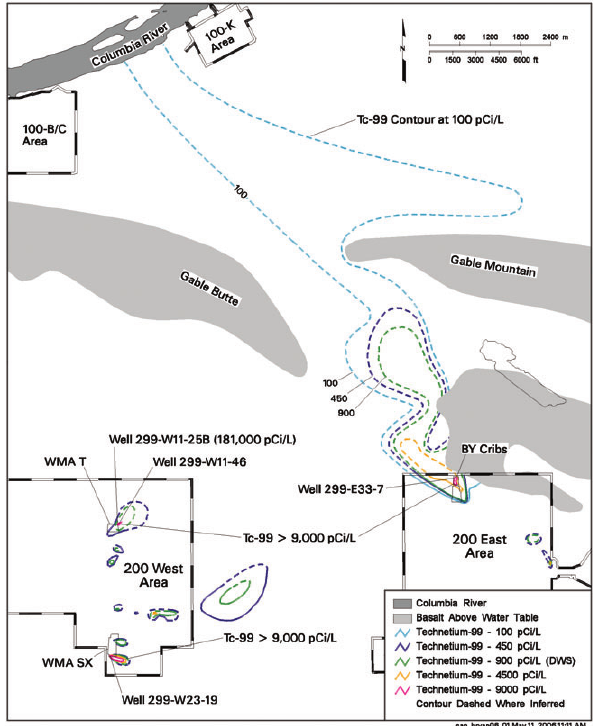
Figure 1 Regional plume map showing 99 Tc in the vicinity of the Hanford Site. The large plume marks the Tc found in groundwater (units in pCi/l). The plume is migrating northwest and has reached the Columbia River and has a source in the 200-East Area of the Hanford Site ( Hartman et al. 2006 ).